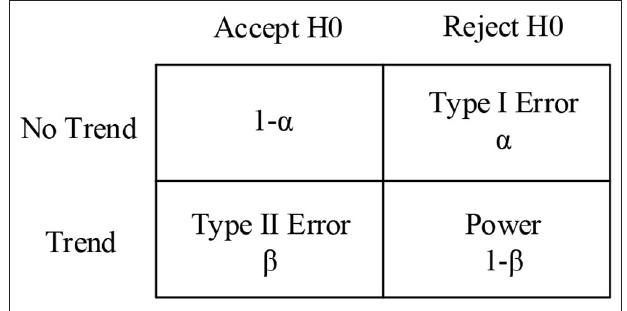
FIGURE 1 | Probability matrix for the MK test, with the null hypothesis H0 showing no trend.